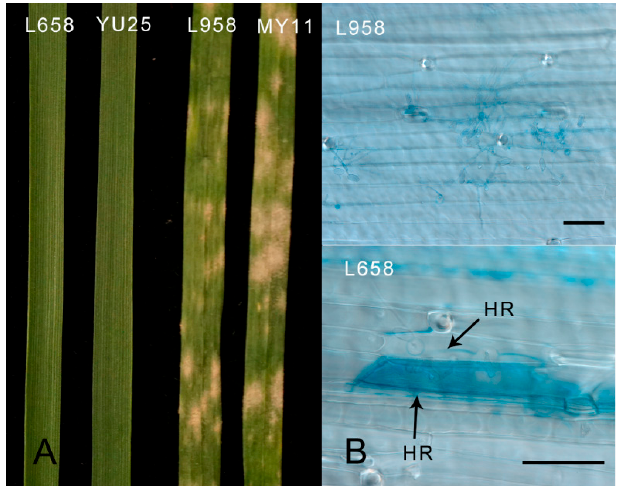
Figure 1. Resistance evaluations and cytological observations of cell death. ( A ) Resistance evaluations after 14 days of inoculation with Bgt at the seedling stage in wheat lines L658, YU25, L958, and MY11. ( B ) Hypersensitive response (HR) observed in wheat line L658 carrying Pm40 and wheat line L958 lacking Pm40 after 72 hpi. The dark bar indicates 50 μ m.